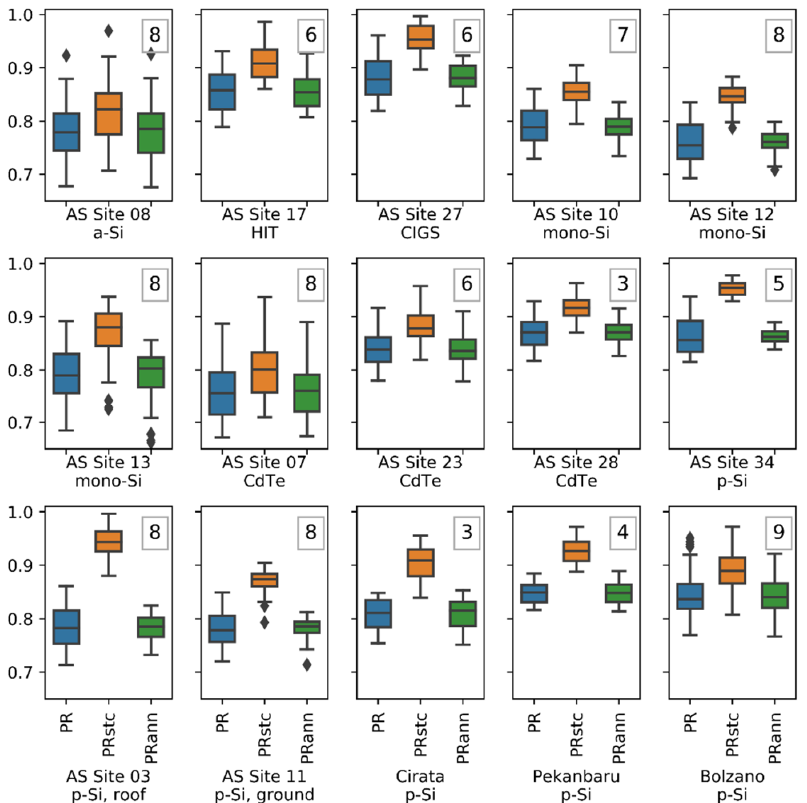
Figure 6. Box plots of the performance ratio of each PV system. Left/blue: PR, middle/orange: temperature-corrected PR by STC, right/green: annual-averaged temperature-corrected PR. Numbers at the upper right corners in the boxes indicate the duration of the analyzed data in the number of years.